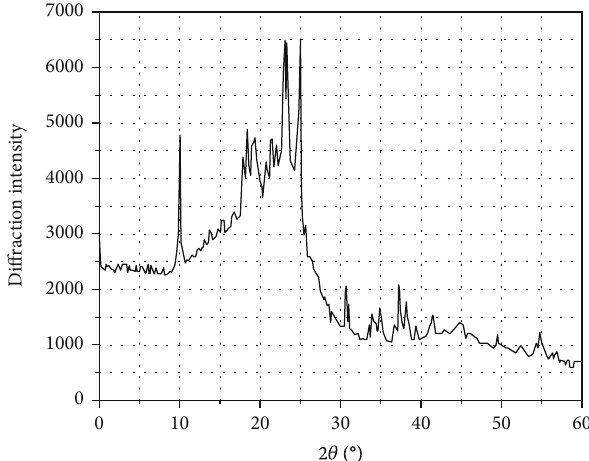
Figure 2: X-ray di ff raction patterns of the coal